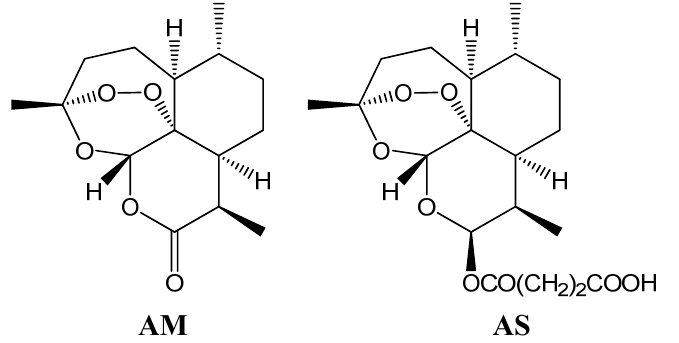
Figure 1. Structures of artemisinin (AM) and artesunate (AS).